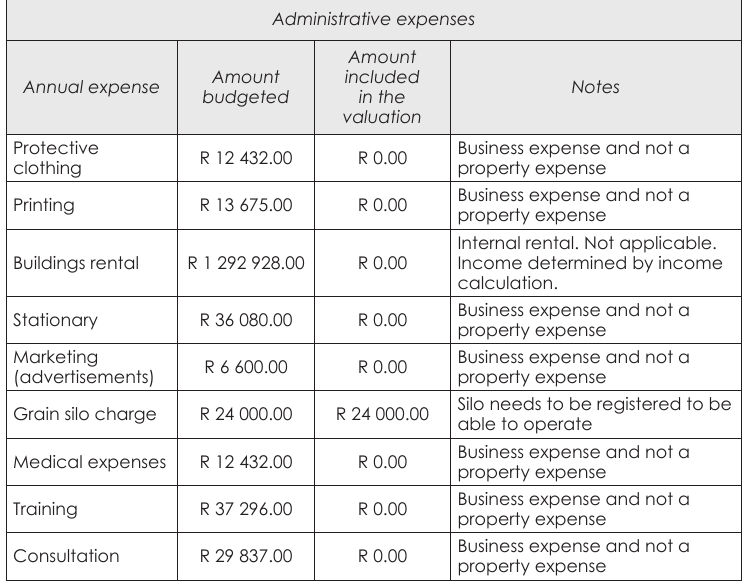
Table 8: Administrative expenses to deduct Administrative